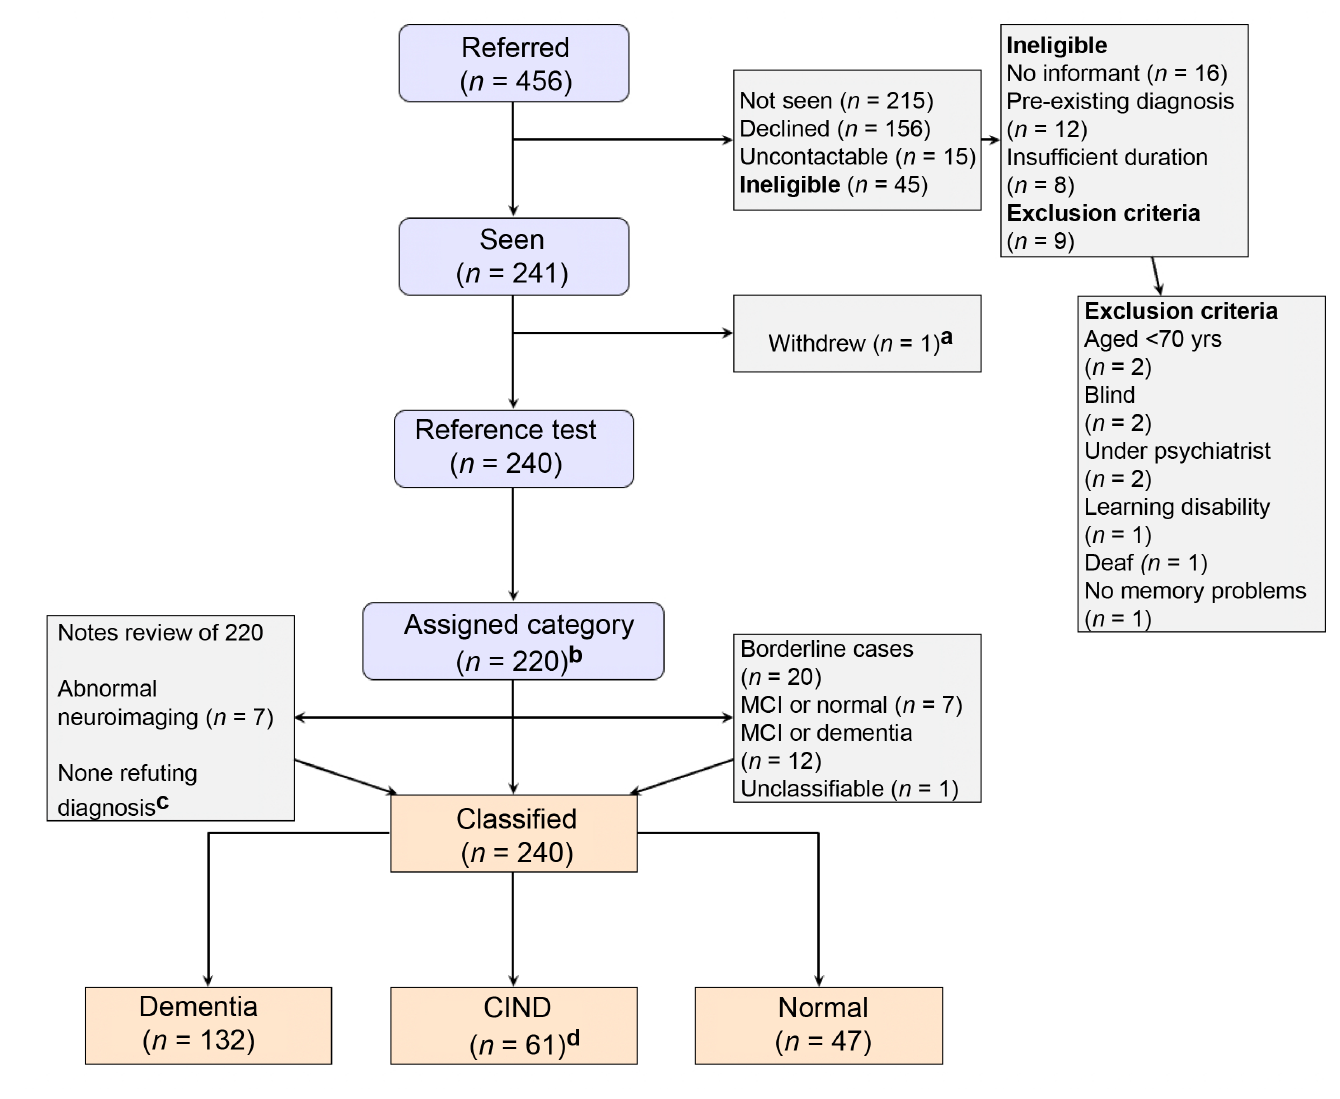
Figure 1 STARDdem flowchart for inclusion of participants in the study. CIND = cognitive impairment not dementia. ICD-10 = International Classification of Diseases, 10th revision. MCI = mild cognitive